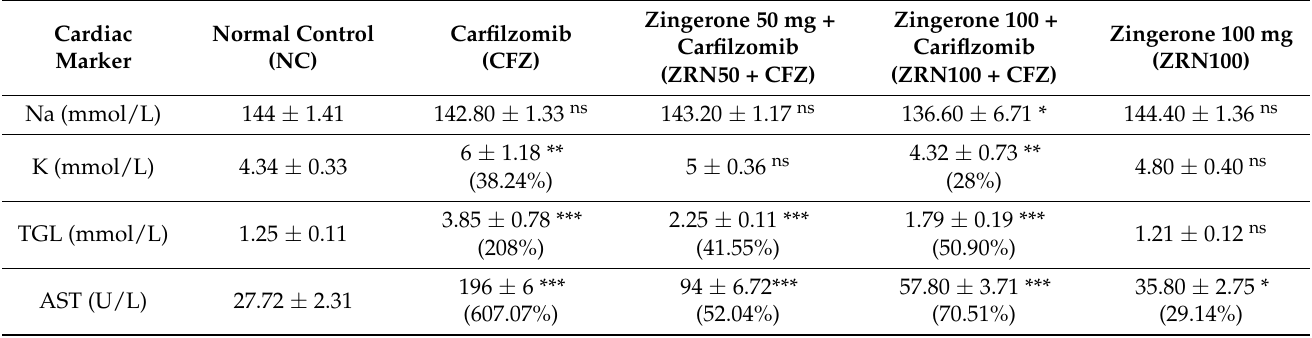
Table 1. The effect of zingerone on hematological markers against Carfilzomib-induced cardiotoxicity in rats.